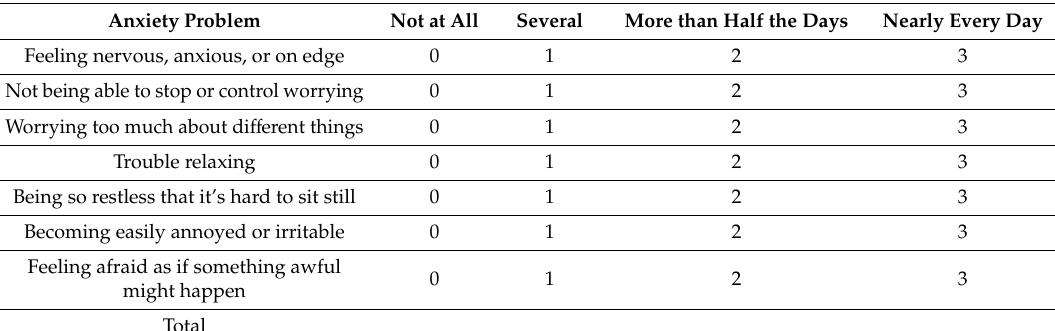
Table A2. General Anxiety Disorder-7 (GAD-7).